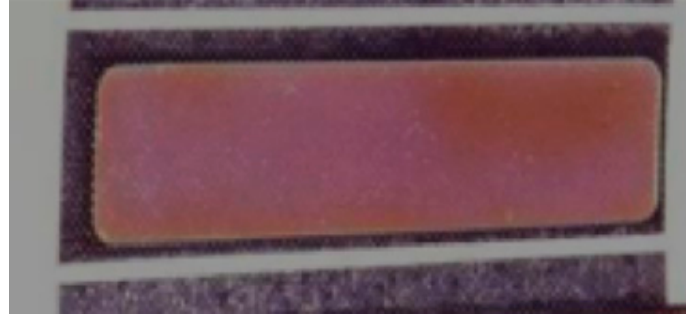
Figure 7. Photograph of a textile-based dye sensitized solar cell developed by Opwis et al.